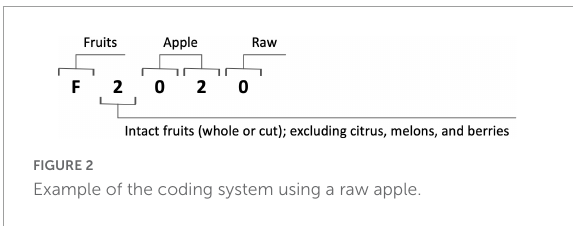
and HEI-2015 were calculated using the created metric and original FPED